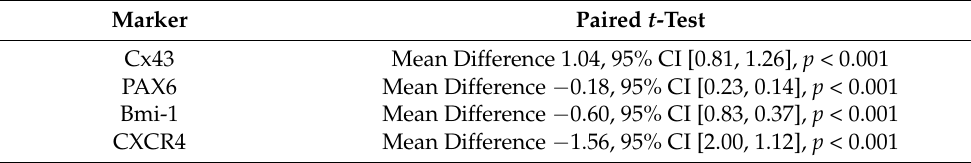
Table 2. Paired student t -test of nMedFI for each indicative stem cell marker and coating condition.